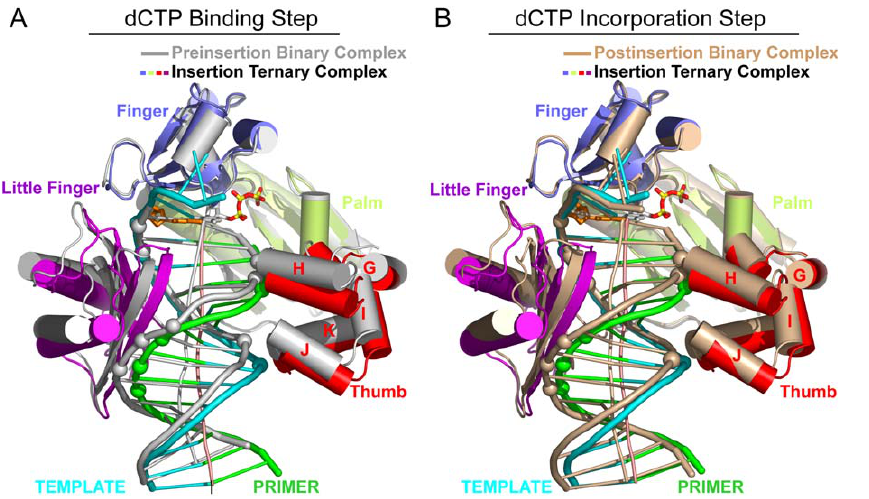
Figure 9. Conformational Transitions of Dpo4 and oxoG-Modified Template-Primer DNA Associated with Nucleotide Binding and Covalent Incorporation Steps Following Superimposition of Dpo4 Palm and Finger Domains (A) Overall comparative views (following superimposition of Dpo4 palm and finger domains) of the structures of the preinsertion binary complex (in silver) and the insertion ternary complex with incoming dCTP (in color). The DNA-backbone phosphate groups in contact with the Dpo4 little-finger and thumb domains are shown as spheres. Upon dCTP binding, DNA slides one step along the little-finger domain, and the oxoG residue of the template strand of the insertion ternary complex takes the place of C7 in the preinsertion binary complex. (B) Overall comparative views (following superimposition of Dpo4 palm and finger domains) of the structures of the insertion ternary complex with incoming dCTP (in color) with the postinsertion binary complex after covalent cytosine incorporation (in beige). DOI: